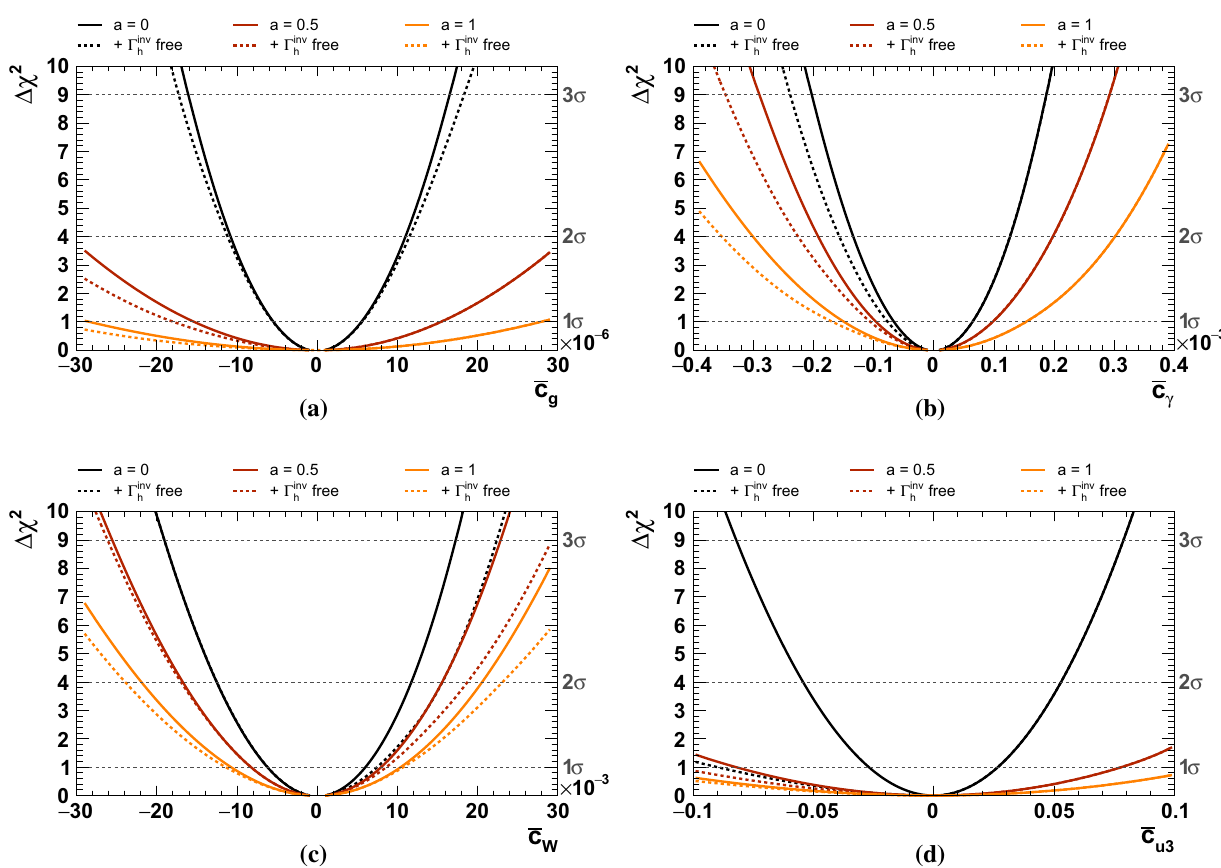
Fig. 2 Scans of the sum of squared residuals (cid:12)χ 2 as a function of the Wilson coefficients ¯ c g , ¯ c γ , ¯ c W and ¯ c u , 3 (from top left to bottom right), obtained by using signal-strength measurements only. Different